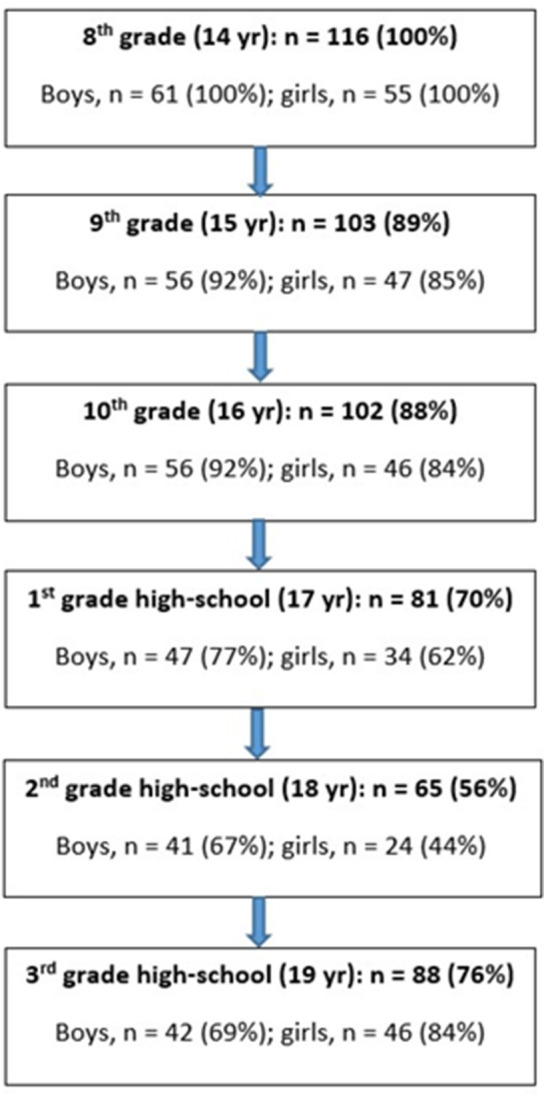
Flow-chart showing the number of subjects tested each year.